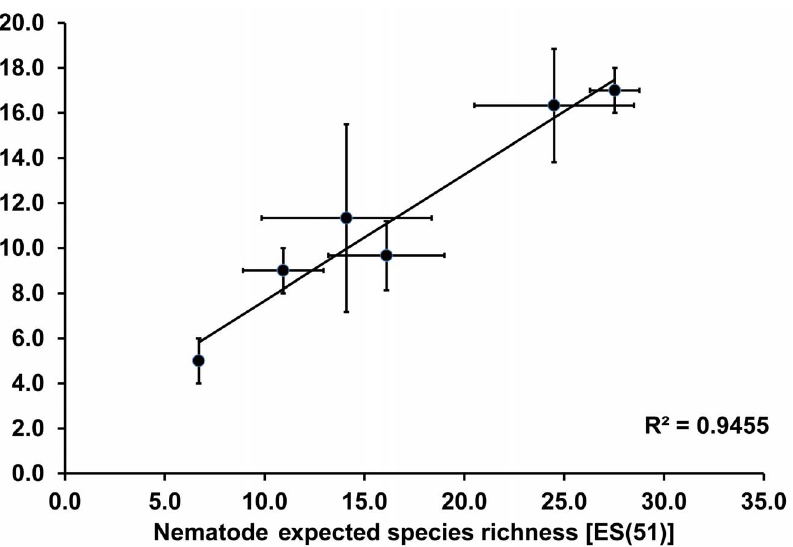
Figure 7. Relationship between richness of meiofaunal taxa and nematode biodiversity as ES(51) in tropical habitats from different oceanic regions. Illustrated are mean values 6 standard deviation.